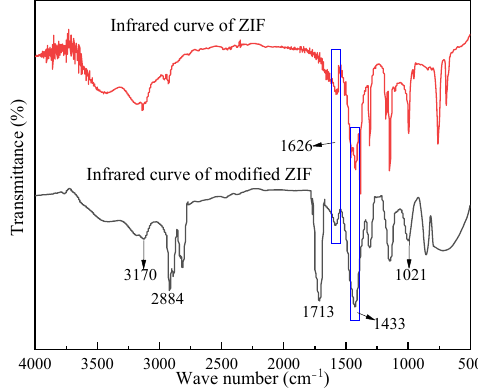
Figure 3. FTIR spectra of ZIF and modified ZIF.